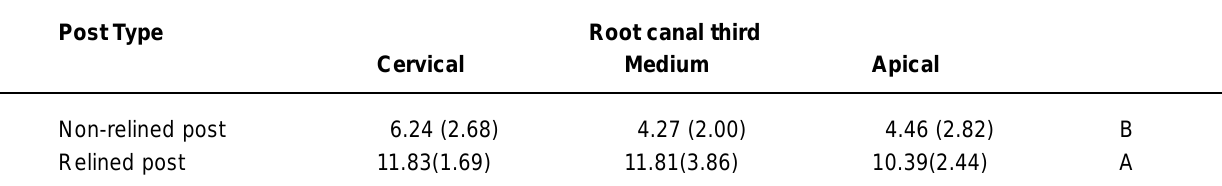
Values are expressed as means (standard deviation). Different letters indicate statistically significant difference (p <